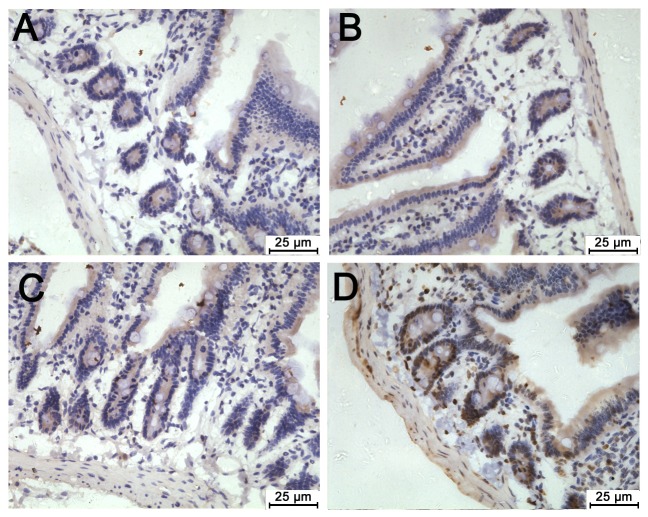
Alterations in IRF-1 and IRF-2 expression in small intestine of KGF treated mice by immunohistochemistry.IRF-1 expression in control group (A) and in KGF group (B), IRF-2 expression in control group (C) and in KGF group (D). Original magnification: ×400; n = 6 per group. Scale bar = 25 µm.